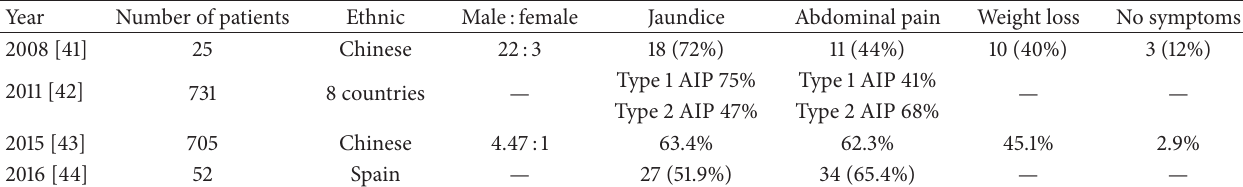
Table 3: Symptoms of AIP in different